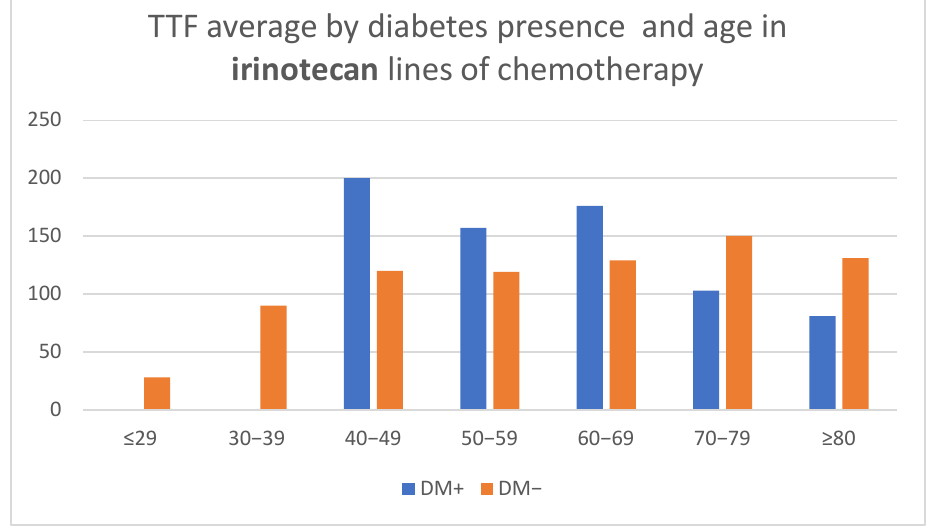
Figure 4. Time to treatment failure (TTF) average by diabetes presence and age in irinotecan lines of chemotherapy.